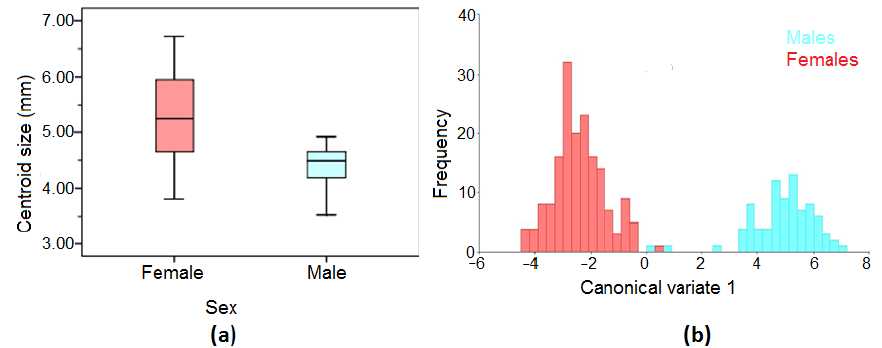
Figure 2. ( a ) Box diagram of centroid sizes for all females and males; ( b ) wing shape diagram of first canonical variable from the comparison of all males (blue) and females (red).